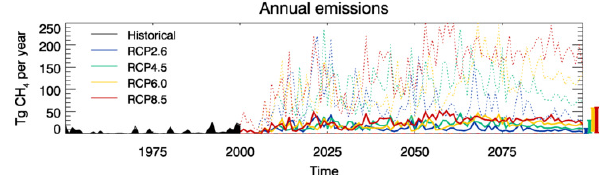
Figure 6. Time series of annual CH 4 emissions for the 4 RCP scenarios in Tg CH 4 per Fig. 6. Time series of annual CH 4 emissions for the 4 RCP scenarios year. The solid line shows the median and dotted and dashed lines show the full spread of in TgCH 4 per year. The solid lines show the median and dotted and values, whilst the bars to the right of the plot show the 5 th - 95 th percentile range. dashed lines show the full spread of values, whilst the bars to the right of the plot show the 5th–95th percentile ranges.